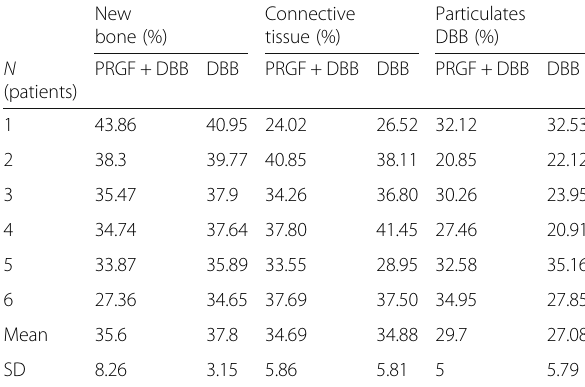
Table 1 Relative volume of new bone formation New bone (%)